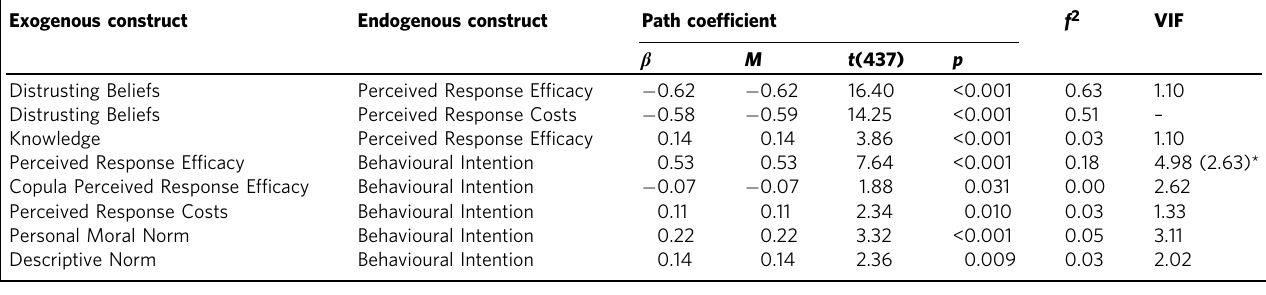
Table 3 Evaluation of the structural model: Bootstrapped path coef fi cient β , effect size f 2 and collinearity (VIF); *VIF value for the model version without copula.